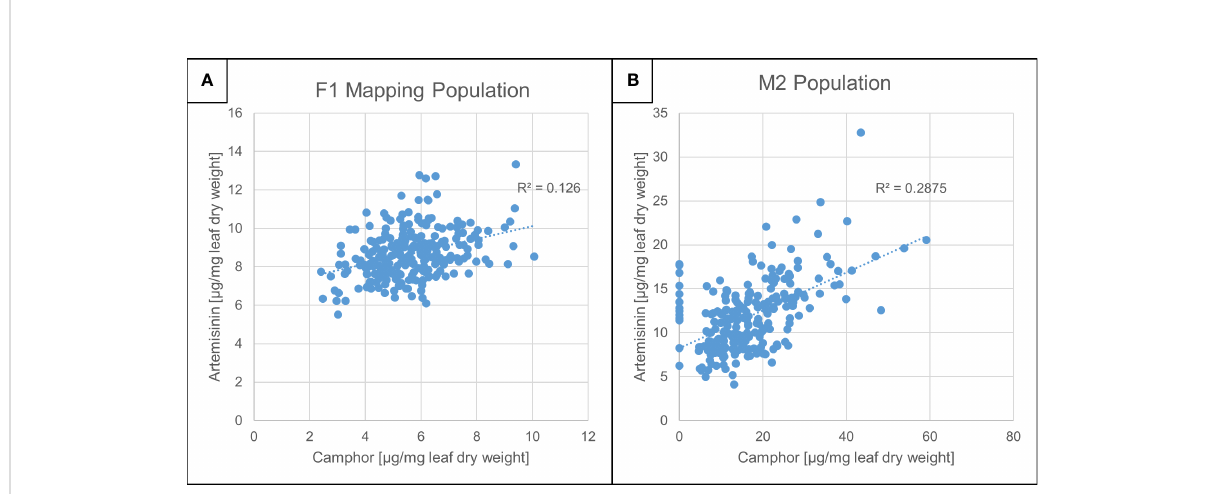
FIGURE 1 Artemisinin and camphor concentration in Artemis F1 mapping- and M2 mutant populations. Camphor and artemisinin concentration in dry leaf material from Artemis F1s (A) and M2 (B) populations grown in Mediplant (Switzerland) fi eld trials (2008). Leaf material was harvested from 248 F1 and 233 M2 individuals, extracted and analyzed by ultra-high performance liquid- and gas chromatography – mass spectrometry (UPLC- and GC- MS) as described in Materials and Methods. Camphor and artemisinin levels were quanti fi ed against standard curves using authentic